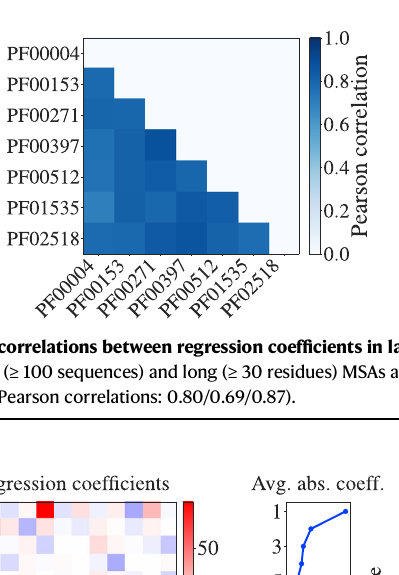
Fig. 4 | Fitting a single logistic model to predict Hamming distances. Our col- lection of 15 MSAs is split into a training set comprising 12 of them and a test set composed of the remaining 3. A logistic regression is trained on all pairwise dis- tanceswithineachMSAinthetrainingset.Regressioncoef fi cients( fi rstpanel)and theirabsolute valuesaveragedoverheadsforeachlayer(secondpanel)areshown